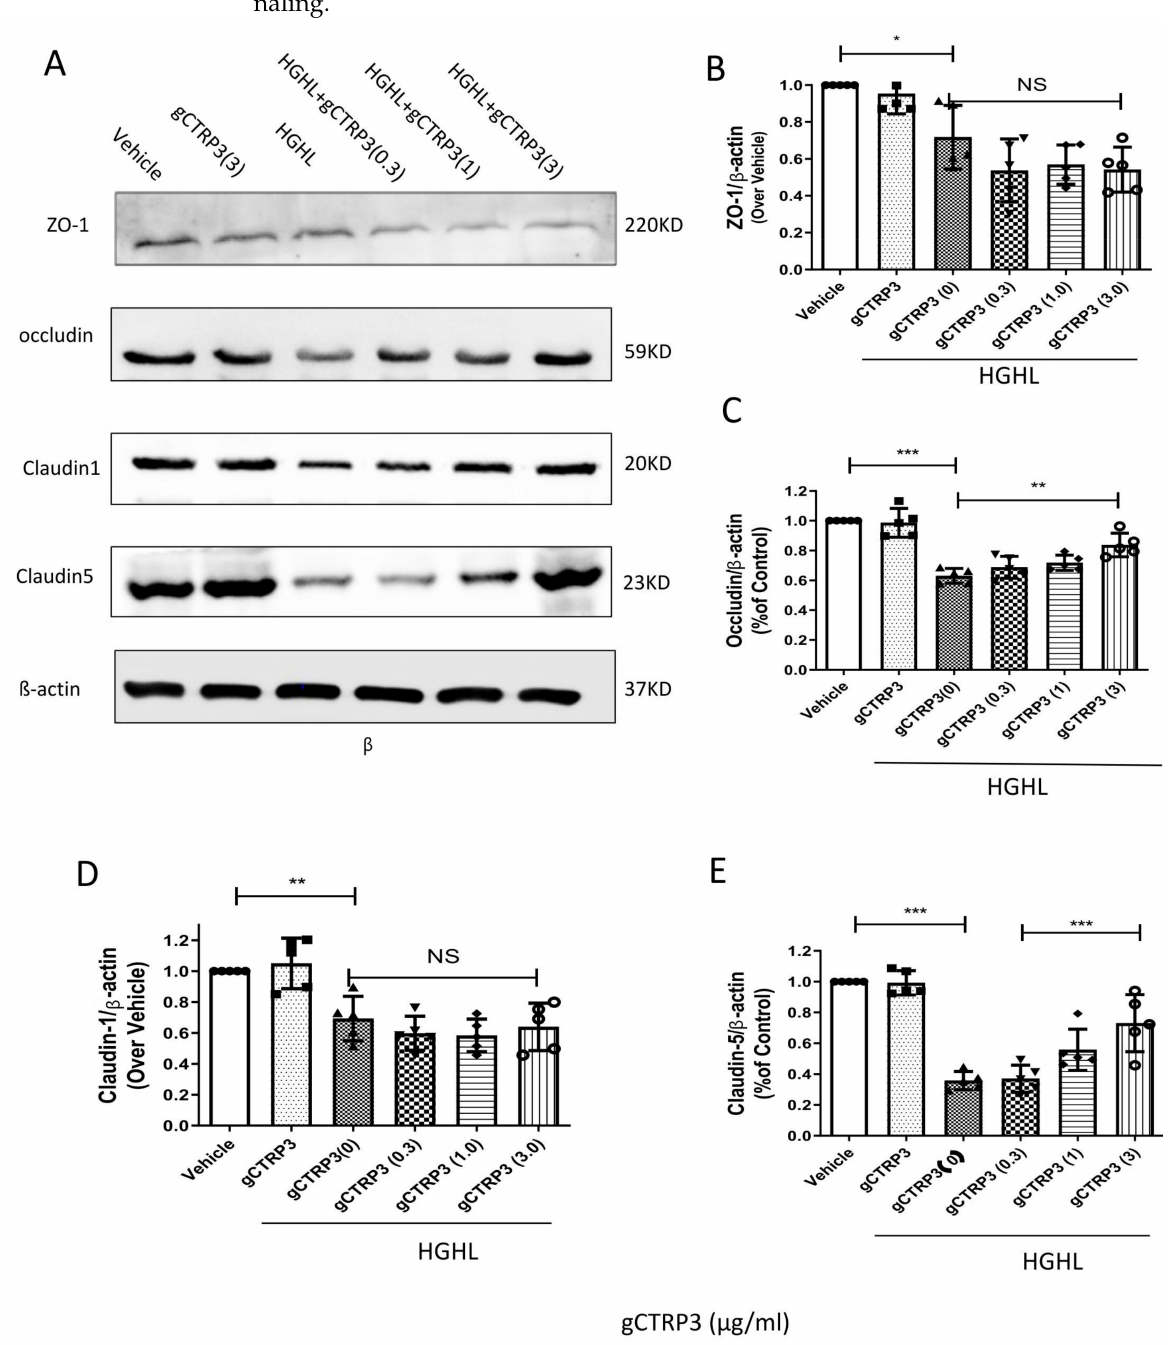
Figure 4. CTRP3 increased Occludin and Claudin-5 expression and protected the integrity of iBRB against HGHL-induced damage. ( A ), Representative immunoblots showing that Claudin-1, ZO-1, Claudin-5, and Occludin protein levels in HRMECs pre-treated with gCTRP3 (3 µ g/mL) followed by HGHL administration. ( B ), Bar graph analysis for quantification of ZO-1 protein expression. ( C ), Bar graph analysis for the quantification of Occludin protein expression. ( D ), Bar graph analysis for quantification of Claudin-1 protein expression. ( E ), Bar graph analysis for quantification of Claudin-5 protein expression. All data are shown as means ± SD. n = 5–7. Bar graph represent analysis from at least 5 independent repeated experiments. * p < 0.05, ** p < 0.01. *** p < 0.001; NS, no